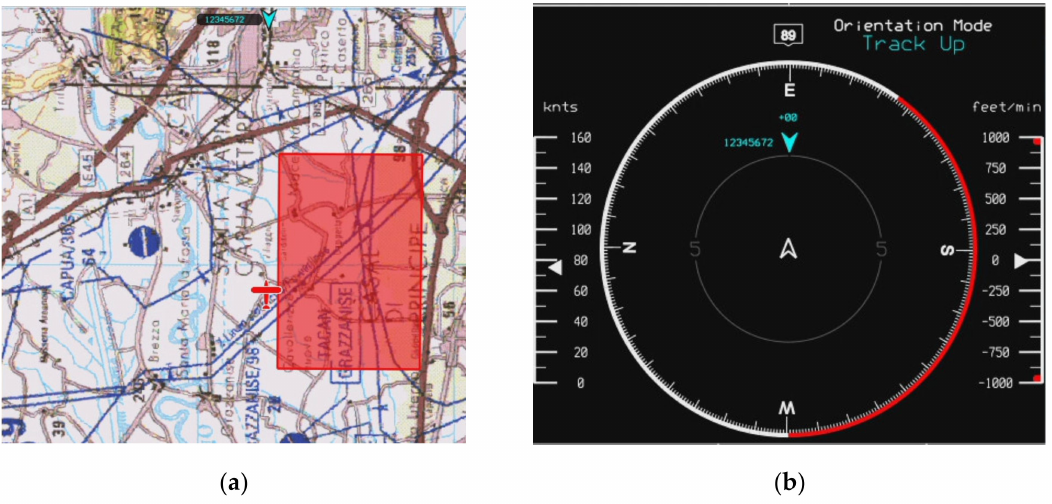
Figure 16. Simulated scenario ( a ) and CDTI conflict band due to the no-fly zone ( b ). During the conflict, the DAA system first shows to the remote pilot the presence of the no-fly zone (red box in Figure 16a) on the right of the own aircraft by displaying a red band (see Figure 16b) that indicates not to turn right.